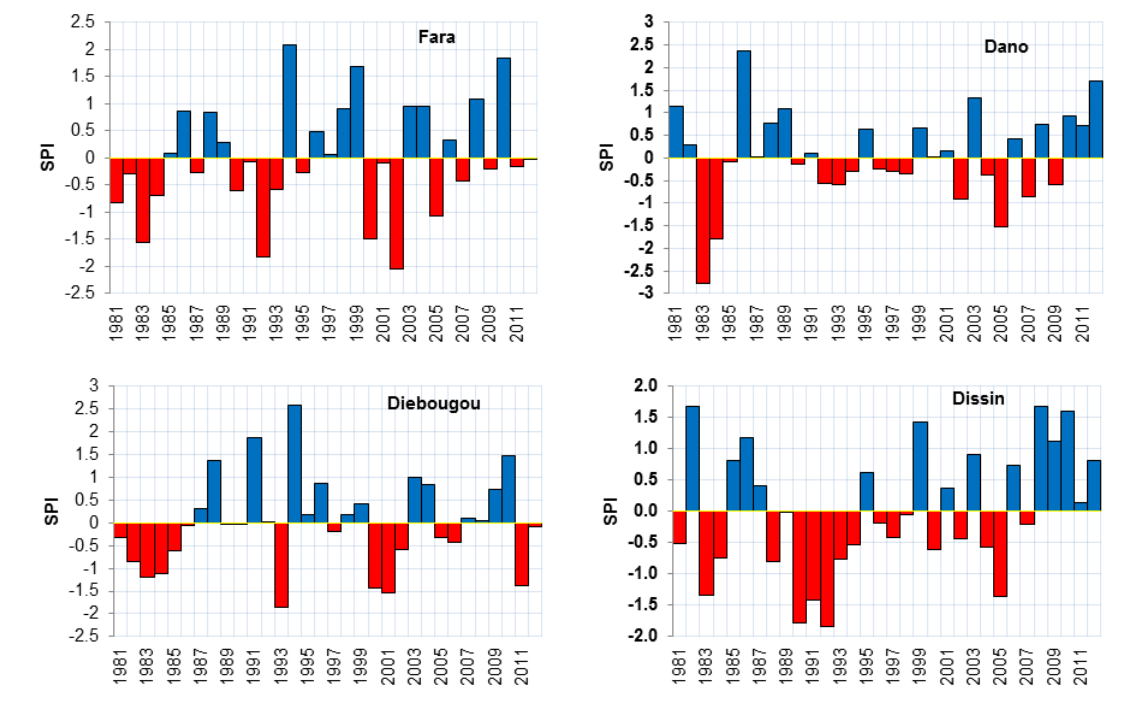
Figure 8. Rainfall variability in the study area (1981–2012) expressed as standardized precipitation index (SPI) distribution (Rainfall data collected from the national direction of meteorology of Burkina